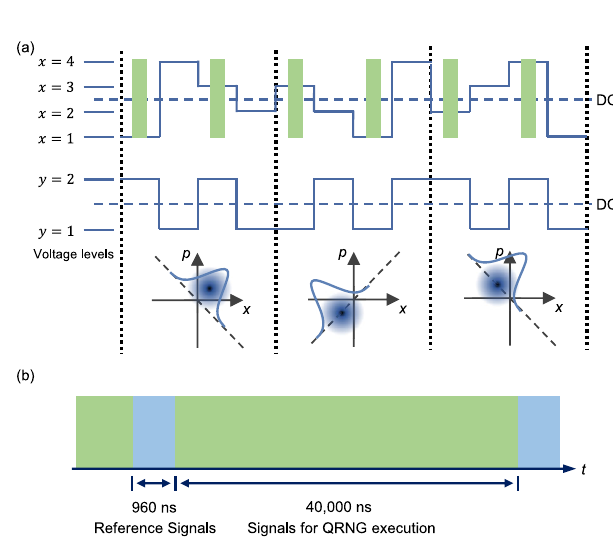
Fig. 2 | Modulation Scheme. a Illustration of the complementary modulation scheme. The blue curves represent the voltage levelsapplied for the signal and LO phasemodulation.Thegreenpulsesrepresentthetemporalmodesforde fi ningthe two-modecoherentstates.Regionsdividedbytheblackdashedlinesrepresentthe quantum state preparation and measurement for a single round of QRNG execu- tion. The constellation diagrams illustrate the distributions of the quadrature measurement with given input settings. b Illustration of the time frame con fi g- uration. Reference signals for phase calibration are prepared and measured amongst the signals for QRNG execution.